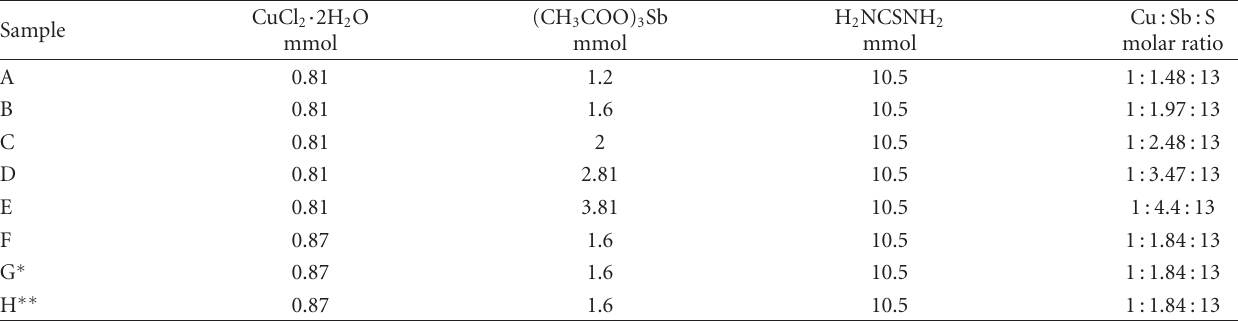
Table 1: Precursor solution